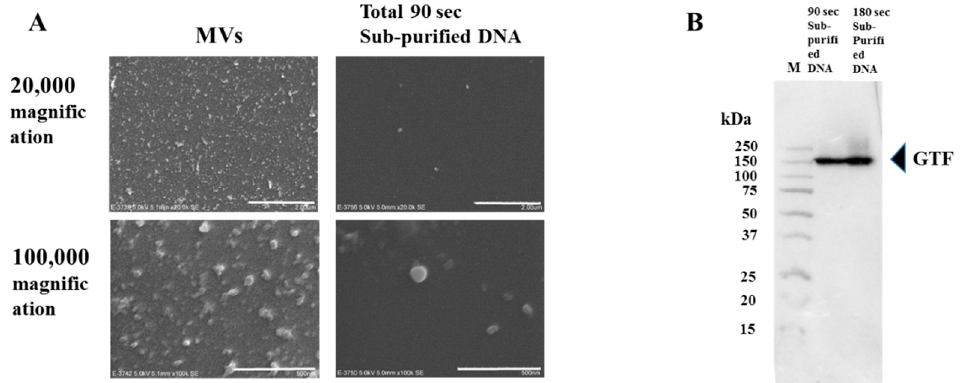
Figure 4. Presence of GTF-I and GTF-SI in sub-purified DNA. ( A ) Membrane vesicles (MVs) and sub-purified DNA prepared by beads destruction for a total of 90 s from S. mutans UA159 were observed at 20,000 and 100,000 magnifications by electron microscope. The independent experiments were performed three times, with similar results obtained in each. ( B ) Sub-purified DNAs prepared by beads destruction for 90 and 180 s in S. mutans UA159 were applied into SDS-PAGE and western blotting using anti-GTF antiserum was performed. Representative data from more than three independent experiments were presented in the pictures.